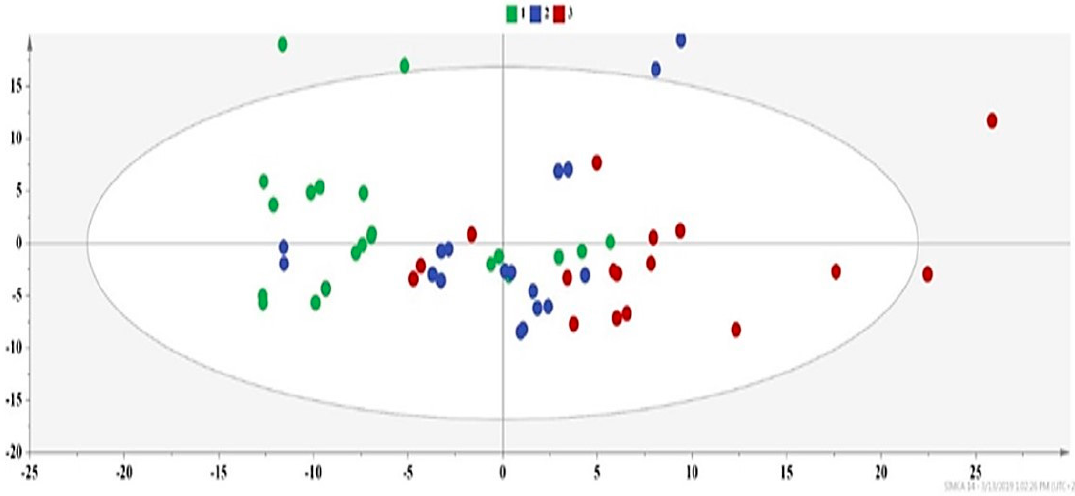
Figure 7. PCA of DOE-extracts excluding Folch samples PCA-X, where A = 2, N = 54, R 2 X(cum) = 0.87, Q 2 (cum) = 0.67, green dots = apricot pulp samples with a low extraction yield ( ≤ 5 mg carotenoids 100 g − 1 dry sample), blue dots = apricot pulp samples with a medium extraction yield (5–15 mg carotenoids 100 g − 1 dry sample), and red dots = apricot pulp samples with a high extraction yield ( ≥ 15 mg carotenoids 100 g − 1 dry sample).